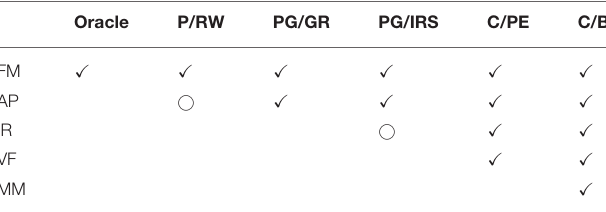
Ticksmarktheexistenceordependenceoftrainablenetworkcomponents;circlesindicate independent intervention. Top row: P/RW, random-walk policy; PG/GR, policy gradients with rewards drawn from a Gaussian distribution; PG/IRS, policy gradients with intrinsic reward samples; C/PE, curiosity using forward model error; C/B, curiosity from boredom. Firstcolumn:FM,forwardmodel;AP,actionpolicy;IR,intrinsicrewards;VF,valuefunction approximator; MM,